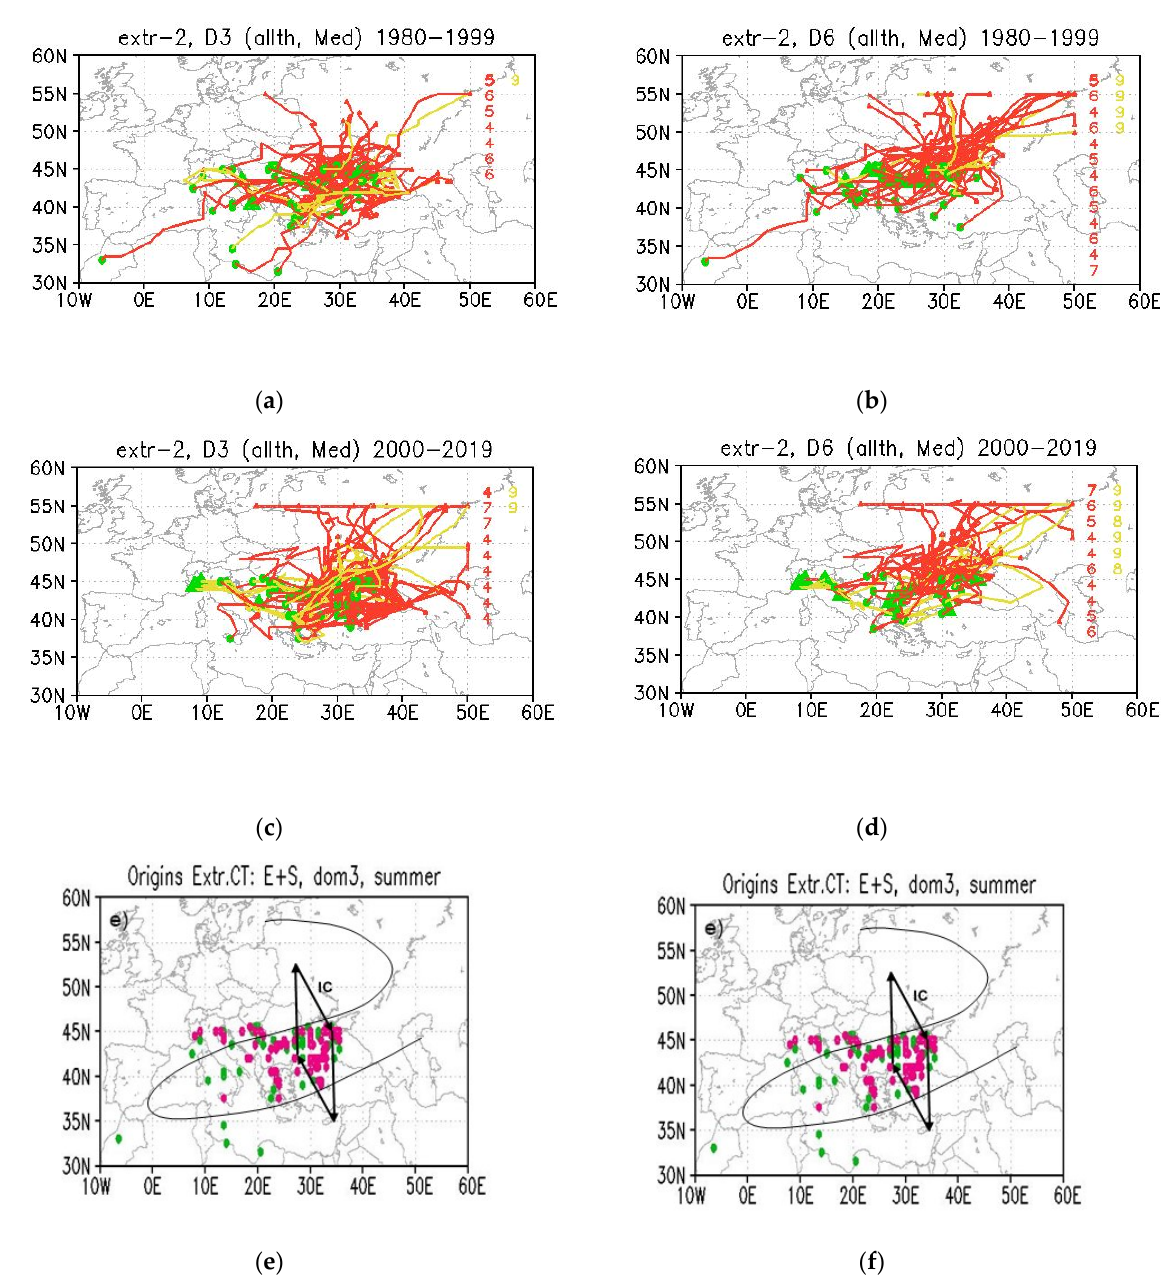
Figure 10. As in Figure 7 for the summer domains: D3 ( a , c , e ) and D6 ( b , d , f ): ( a – d ) dark red is for late spring-originating tracks (AMJ) and yellow for late summer (JAS); ( e , f ) black line schematizes the location of anomalous displacement of polar jet from zonality in P2 relative to P1 in summer AMJJAS. The indirect circulation (IC) in the jet streak exit area is schematized in Figure 10e.